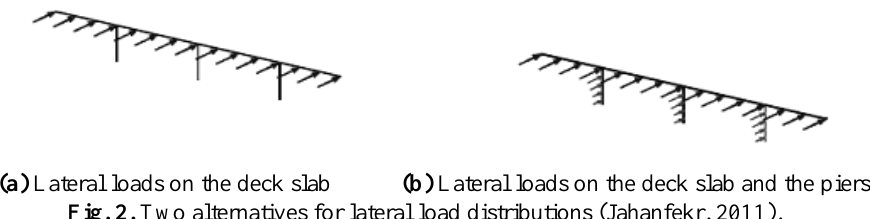
Fig. 2. Two alternatives for lateral load distributions (Jahanfekr,